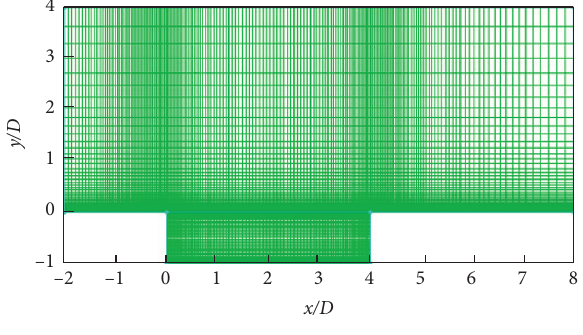
Figure 5: Cavity mesh structure [58].